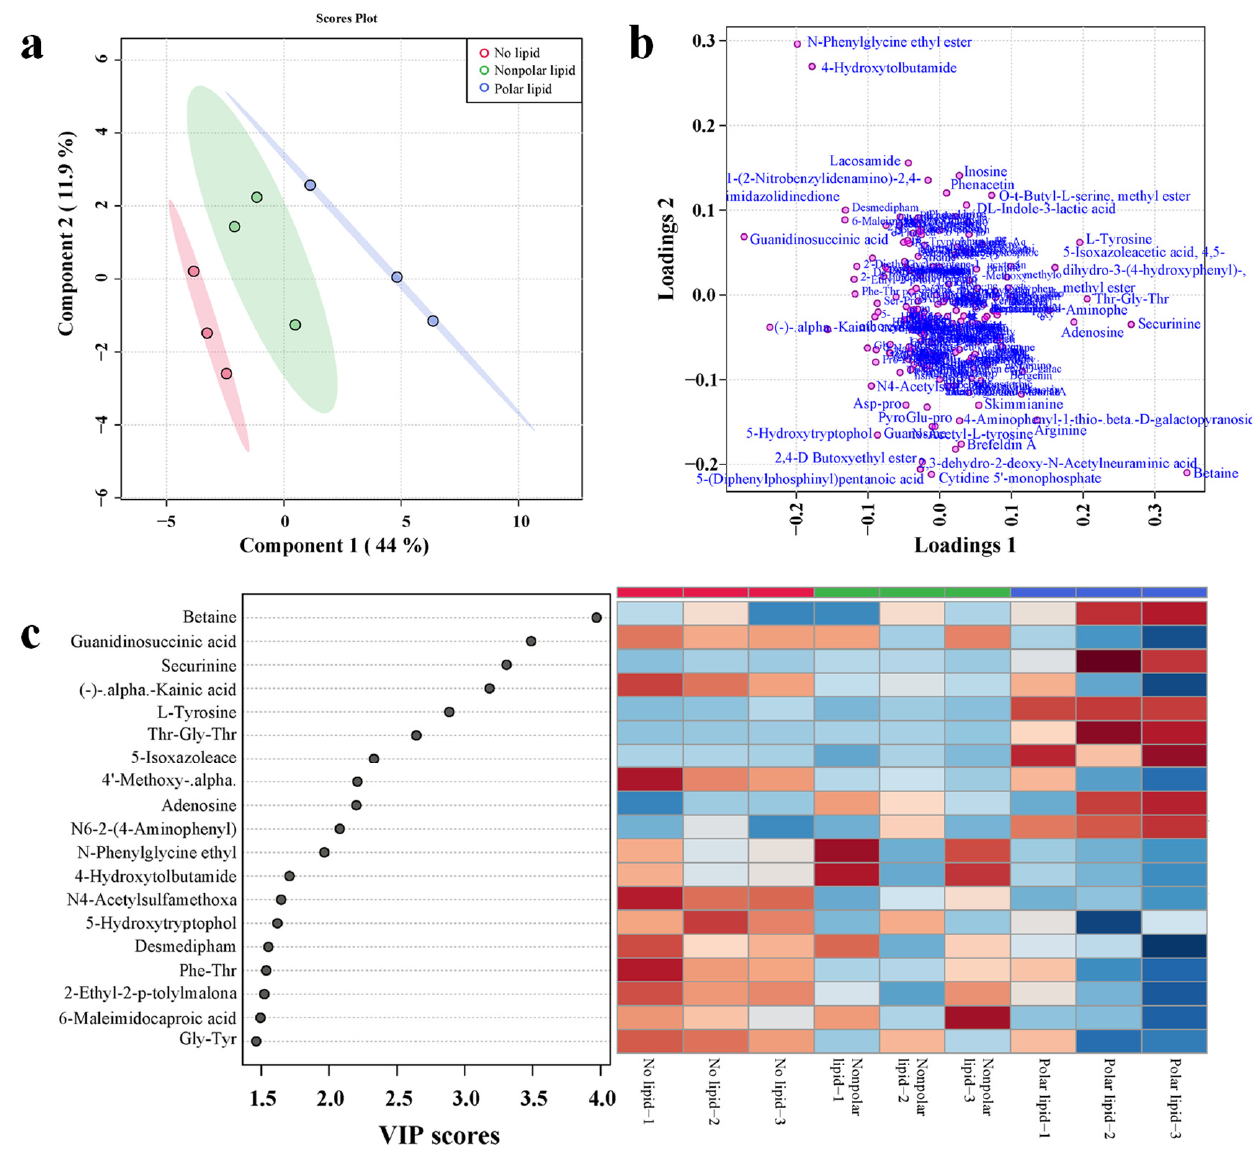
Figure 5. PLS-DA analysis diagram of non-volatile compounds in MRPs with different polarity lipids: ( a ) scores plot; ( b ) loading plot; ( c ) VIP plot and heatmap .